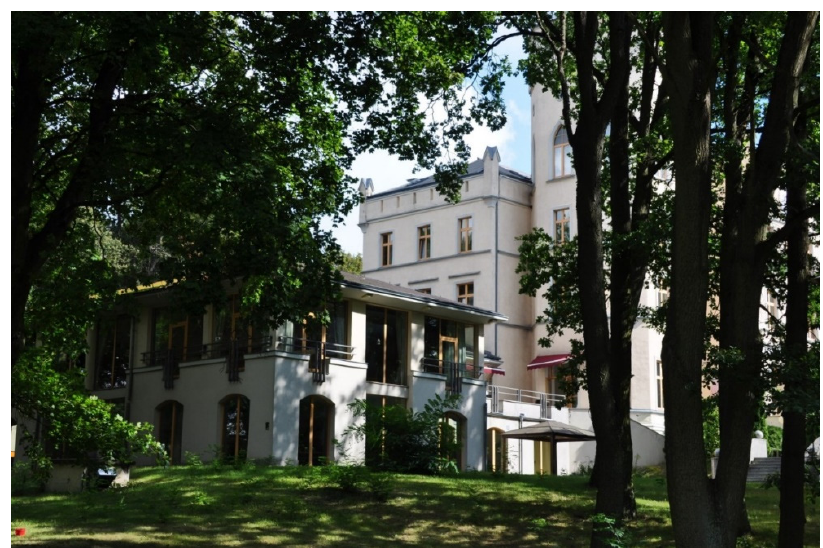
Figure 7. View of the extension of the Palace in Maciejewo, constructed in 2000, with a swimming pool in the ground level and a multifunctional ballroom above; photo: author.